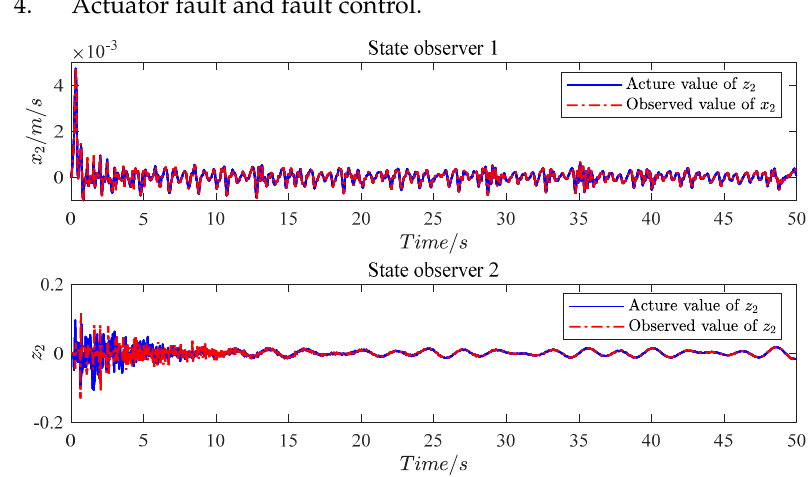
Figure 5. The actual values and observed values of the system state values.